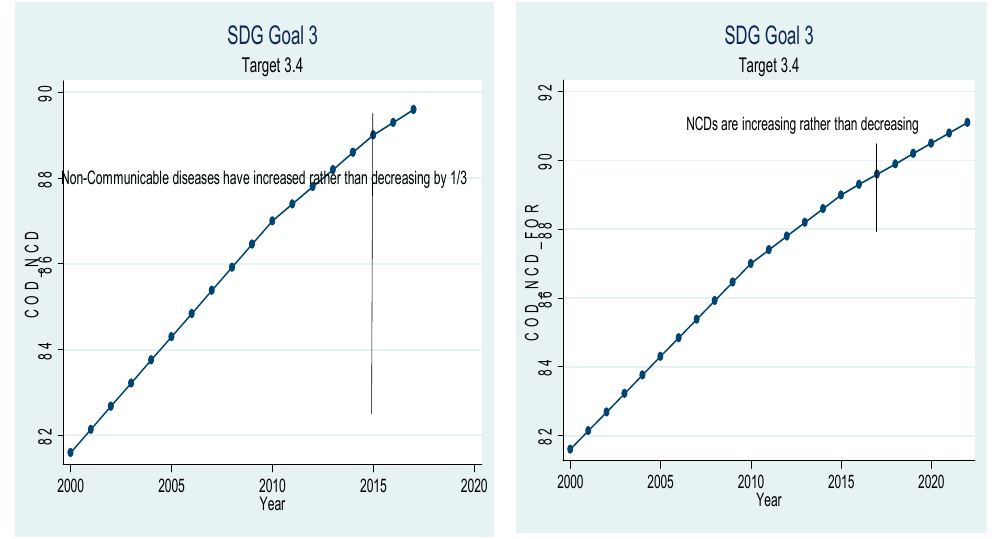
Figure 4. Strategic development goal 3, target 3.4 (mortality from non-communicable diseases) ex-post and ex-ante .